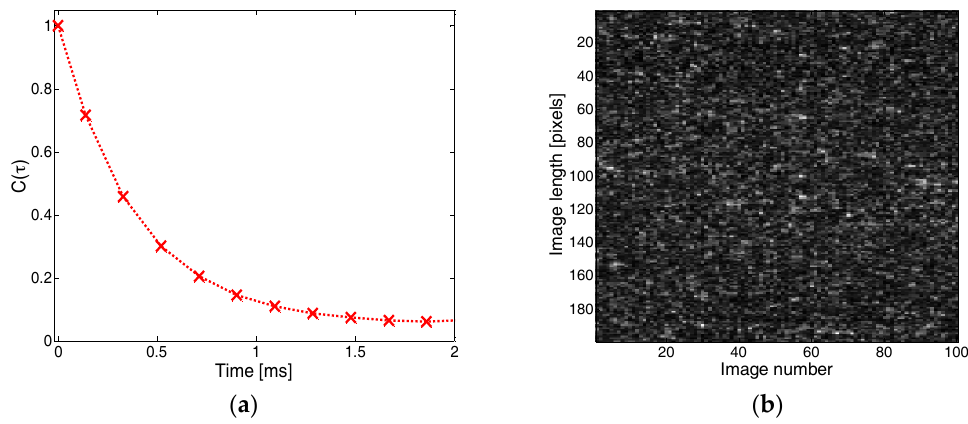
Figure 2. ( a ) Temporal correlation curve C ( τ ) and ( b ) the temporal history of the speckle pattern (THSP) image for a 1.7 mL white wine sample with 0.3 mL of added microspheres with a diameter of 0.22 µm.